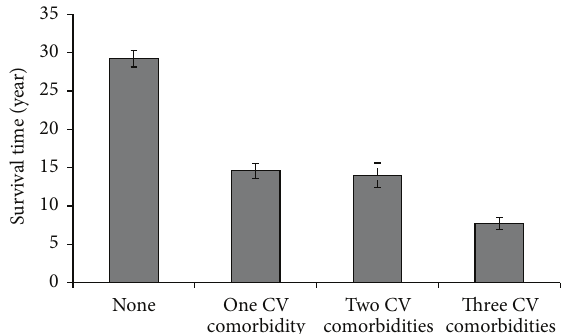
Figure 3: Mean survival time in recruited patients after Parkinson’s disease diagnosis regarding the presence and/or number of cardio- vascular comorbidities ( 𝑝 value for log-rank test <